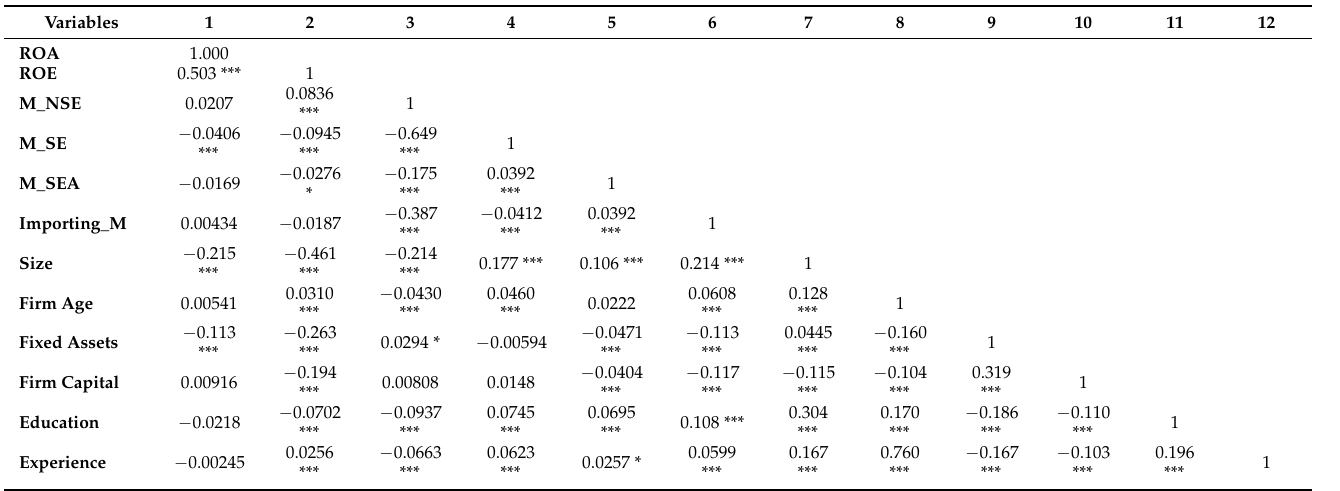
Table 4. Correlation matrix.